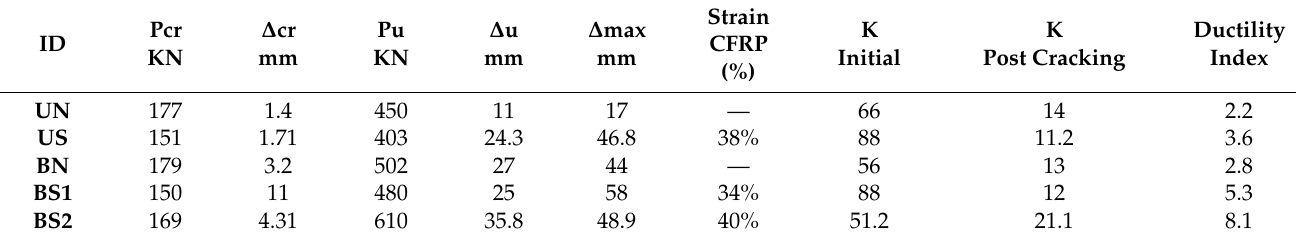
Table 2. Cracking, ultimate loads and deflections for tested slabs.